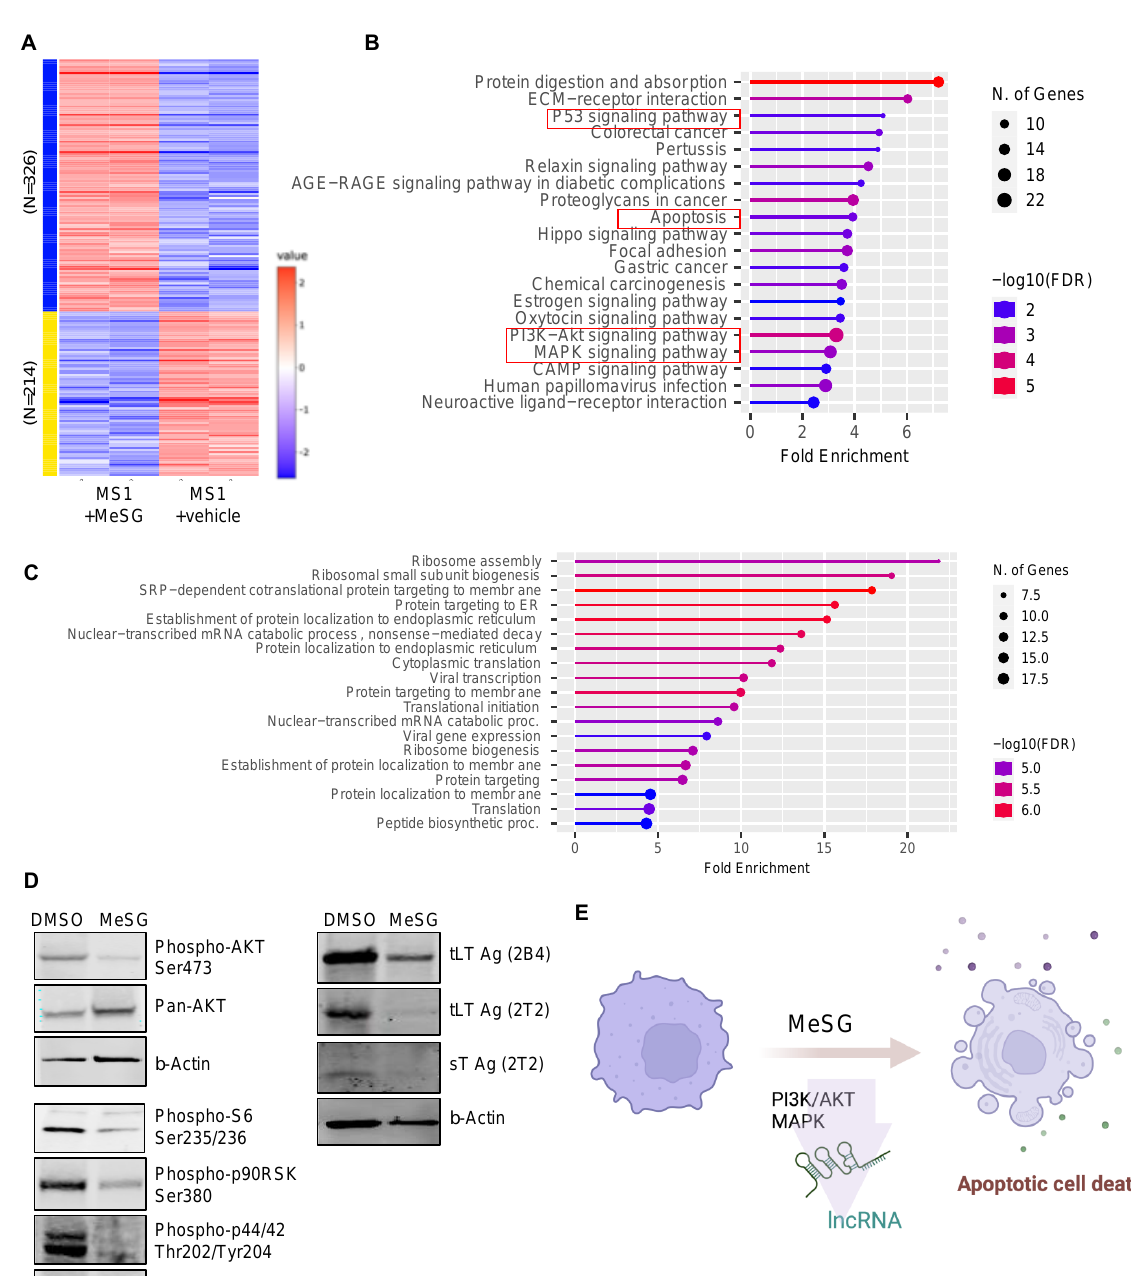
Figure 5. Different gene expression profile of MS-1 induced by MeSG. ( A ) RNA-seq and DEG analysis. Expression heatmap of DEGs between MeSG-treated (100 nM) and non-treated MS-1 control cells (+vehicle) is shown. ( B ) Results of the ShinyGO pathway enrichment analysis for the differentially expressed genes. P53, apoptosis, PI3K/AKT and MAPK signaling pathways were identified as potential biological processes associated with MeSG. ( C ) Gene changes in cancer cell lines (A549